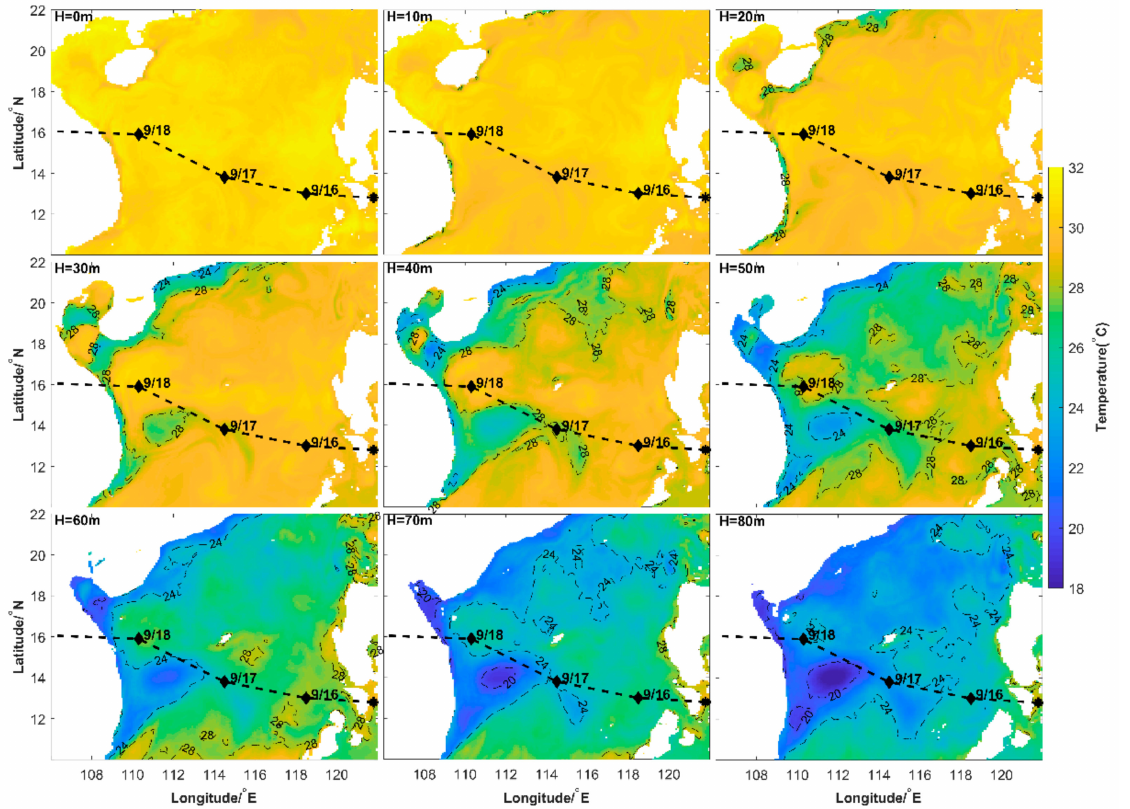
Figure 13. Water temperature from sea surface to 80 m on September 14 obtained from the HYCOM